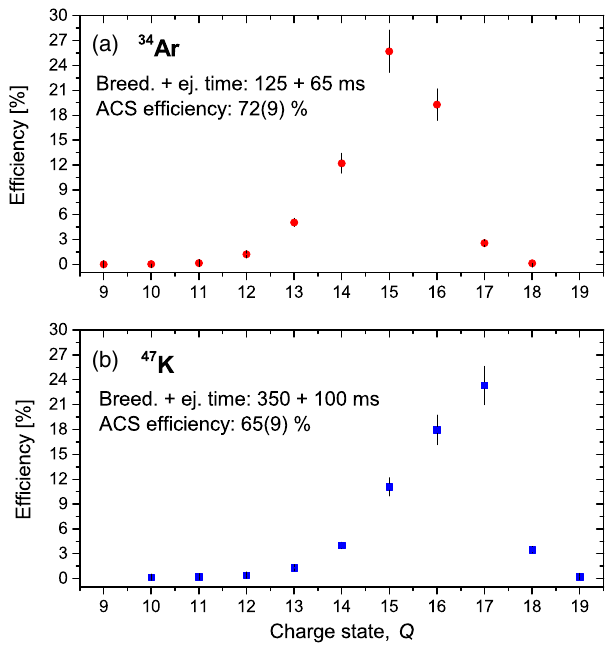
FIG. 10. Efficiency in single charge states (SCS) for (a) 34 Ar and (b) 47 K. 34 Ar 15 þ and 47 K 17 þ were reaccelerated and delivered to nuclear-physics experiments. Also included in these plots are the all-charge-state (ACS) efficiencies calculated by integrating the SCS